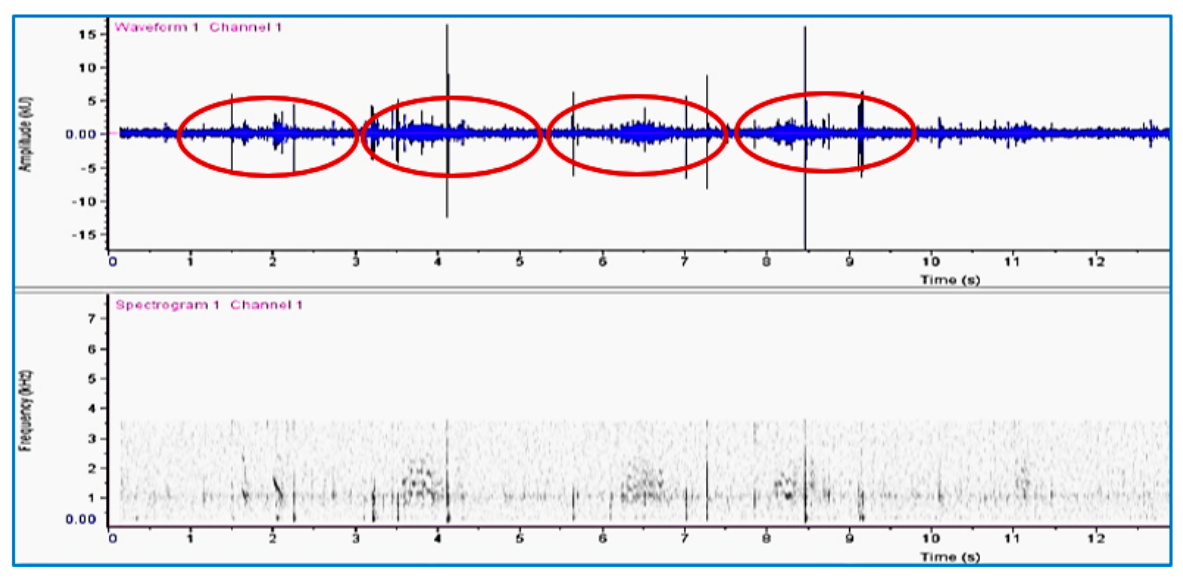
Figure 4. Oscillogram (waveform) and spectrogram patterns produced by activity of red palm weevil larvae inside a water-injected date palm. Three series of high-amplitude feeding activity clicks mixed with bursts of low-amplitude movement impulses are marked with ovals.